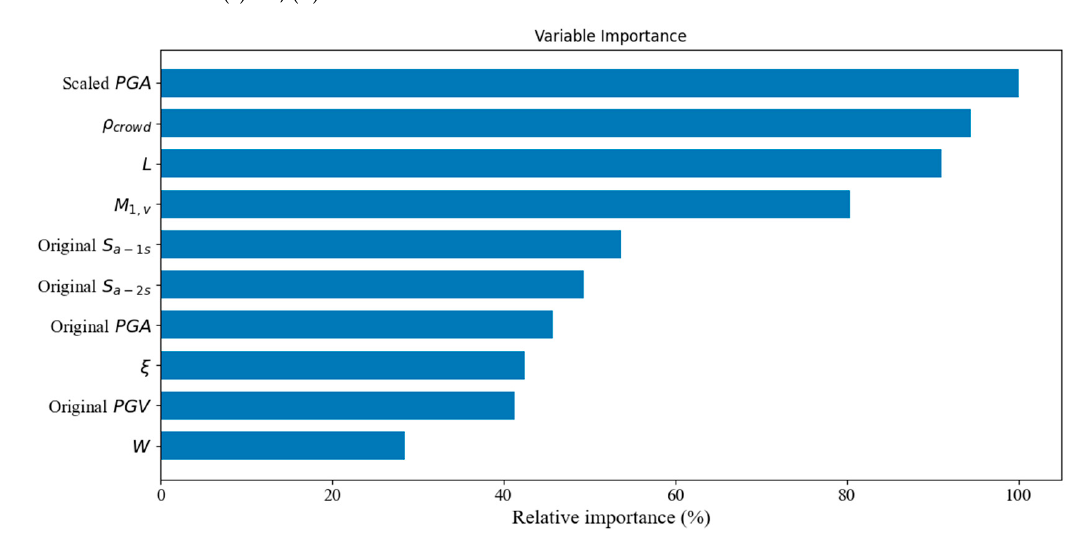
Figure 18. Relative importance of all features (input